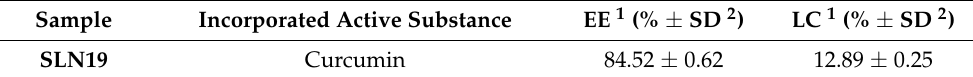
Table 5. Encapsulation efficiency (EE) and loading capacity (LC) of curcumin into SLN-type lipid